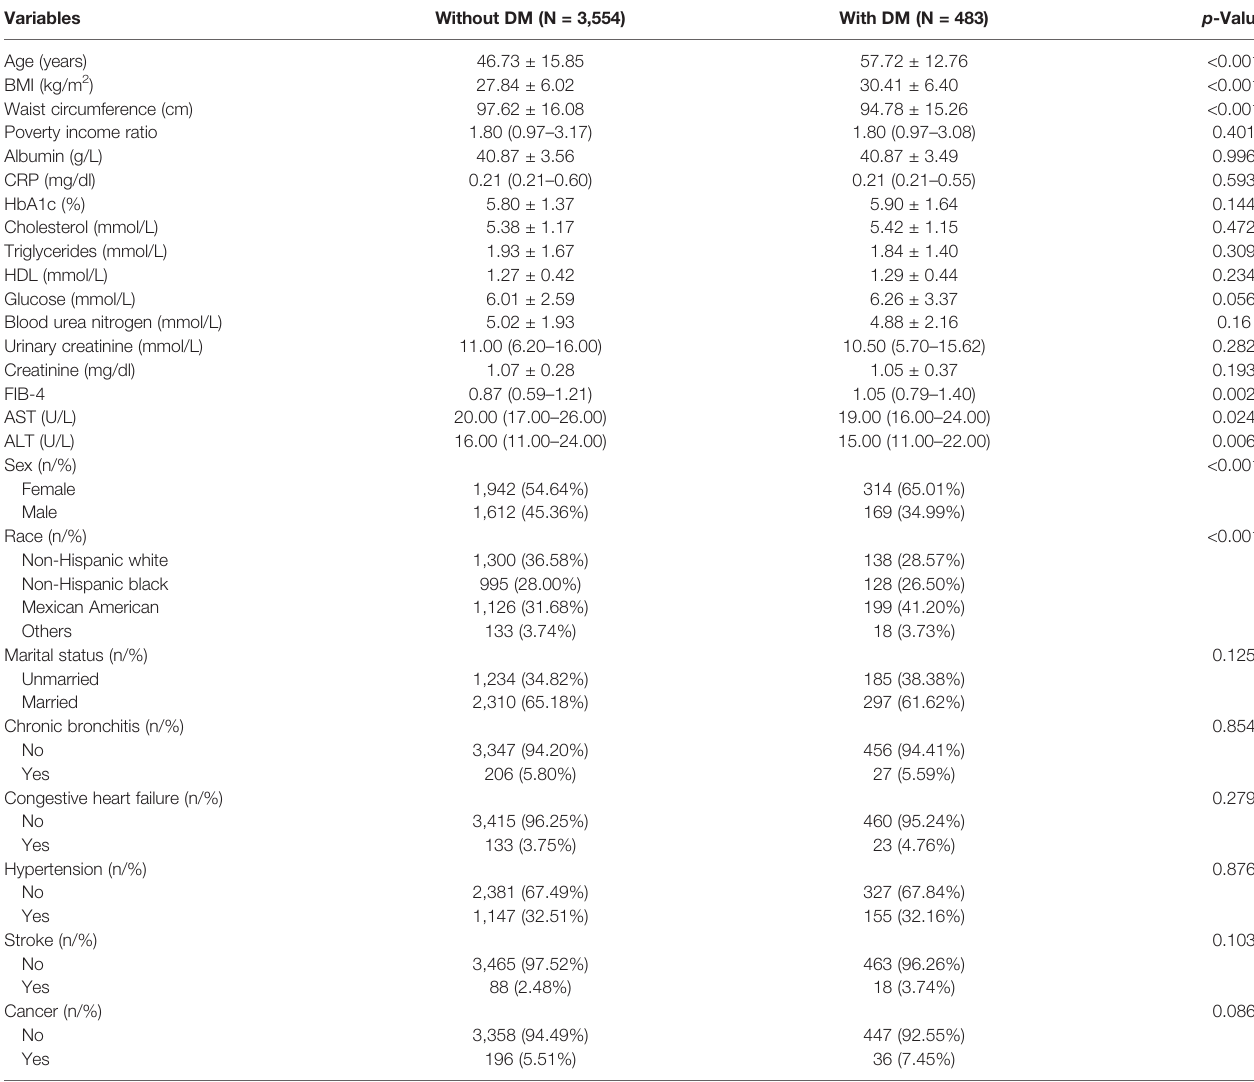
TABLE 1 | Baseline characteristics of the participants by DM in adults aged ≥ 20 years with NAFLD, NHANES 1988 – 1994. Variables Without DM (N =